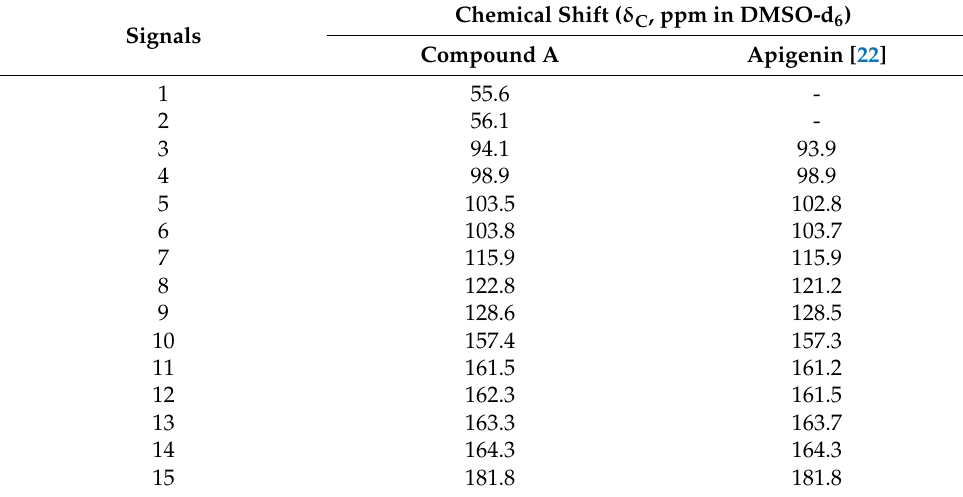
Table 7. 13 C-NMR spectral data of compound A showing similarities with the literature data [22].